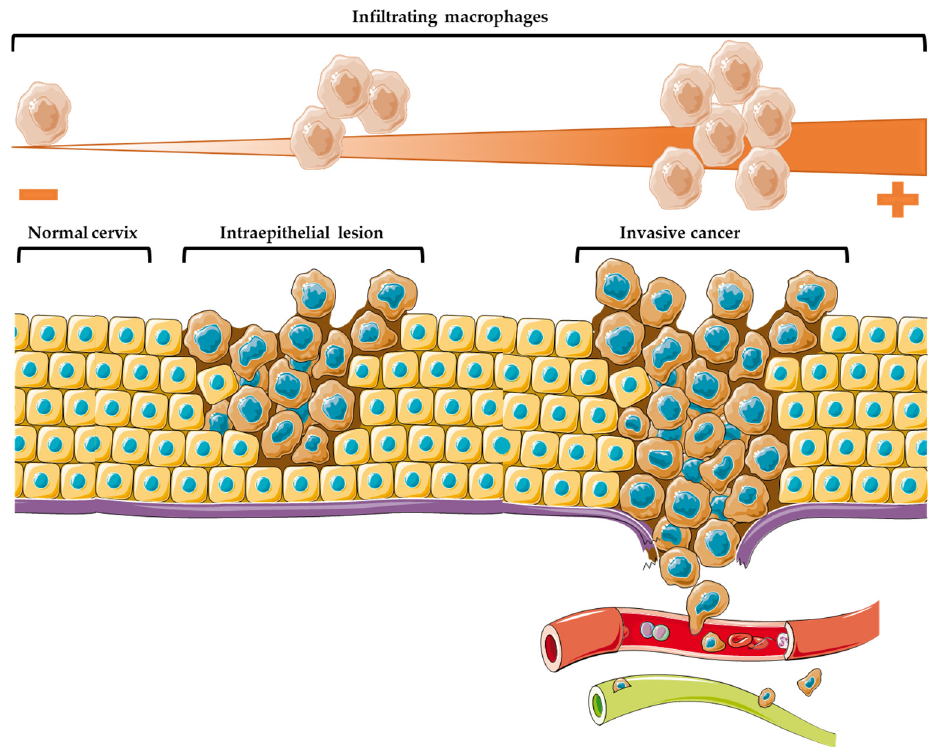
Figure 3 . An increase in infiltrating macrophages might be related to the progression of cancer.